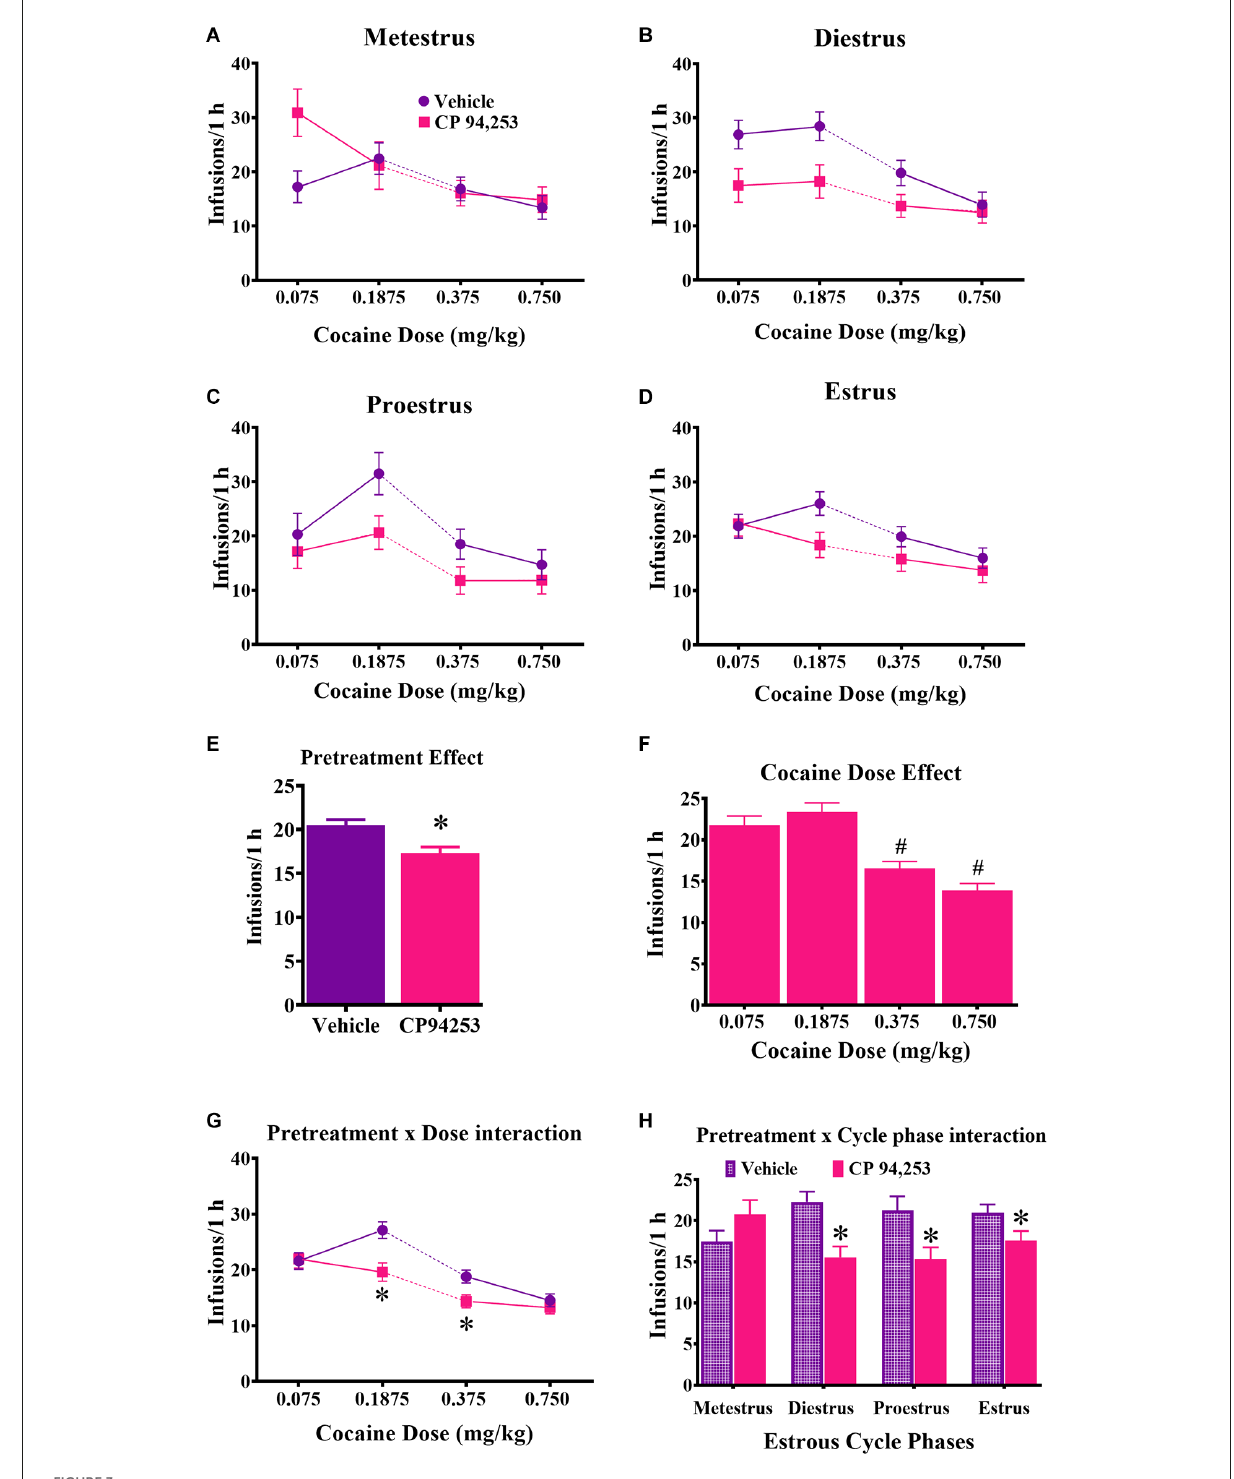
FIGURE3 Effects of the 5-HT 1B R agonist CP94253 on cocaine infusion rate (mean ± SEM) under an FR5 reinforcement schedule in female rats during metestrus (A) , diestrus (B) , proestrus (C) , and estrus (D) , and ANOVA main effects of pretreatment (E) and dose (F) and interactions between pretreatment and dose (G) and pretreatment and cycle phase (H) . For experimental details and n/condition see text or Figure 1 caption. ∗ Difference from vehicle pretreatment, ANOVA main effect, p < 0.05 shown collapsed across pretreatment and estrous cycle phase or post- hoc Bonferroni t -tests, p < 0.0167; # difference from 0.075 and 0.1875 cocaine doses, Bonferroni t -tests, p <